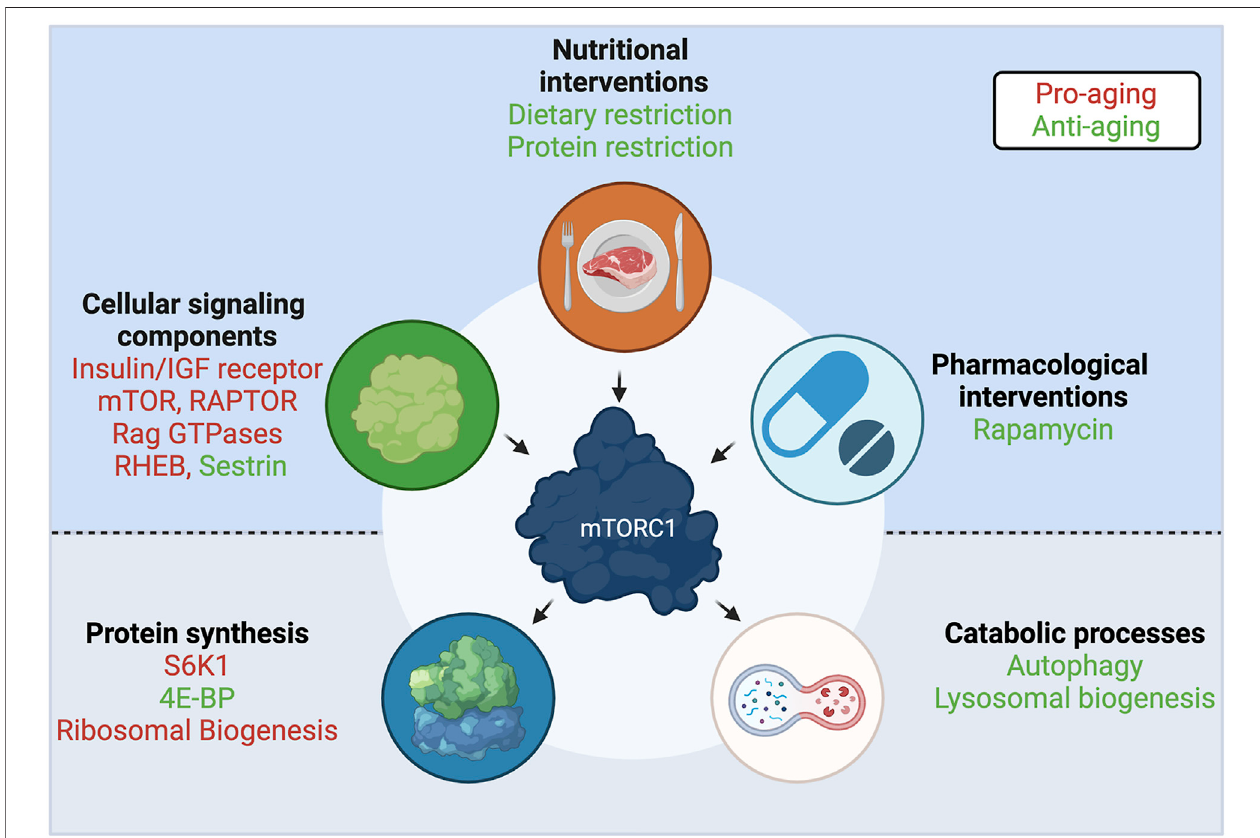
FIGURE 4 | A central role for mTORC1 in aging. Interventions and upstream cellular components that regulate mTORC1 activity, and downstream effectors and functions that are regulated by mTORC1, participate in the aging process. Components with anti-aging properties shown in green; components with pro-aging properties shown in red. See text for details. Created with